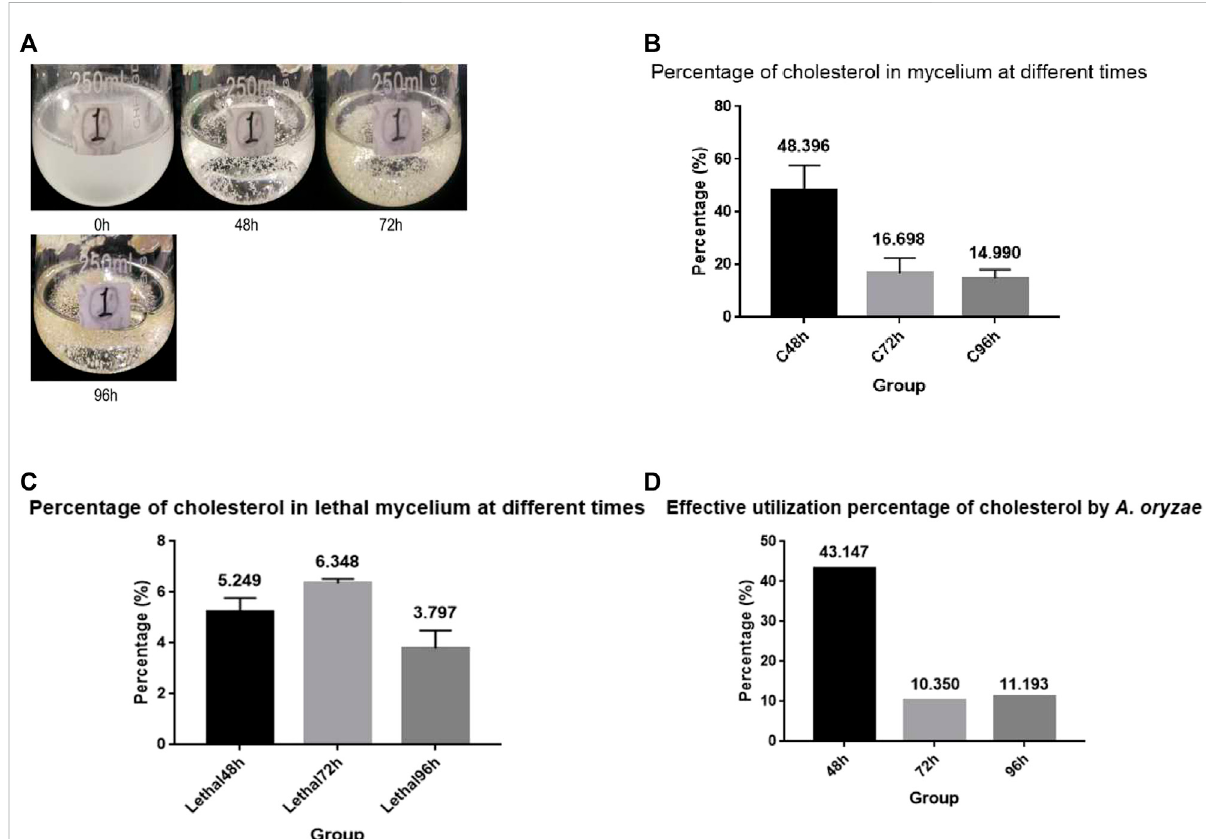
FIGURE 1 A.oryzae canutilizecholesterol. (A) Cholesterolmediumwasfermentedby A.oryzae ,andthegrowthconditionof A.oryzae indifferentperiods of fermentation were determined. (B) The percentage of cholesterol in mycelium dry weight at different time points. (C) The percentage of cholesterolinlethalmyceliumdryweightatdifferenttimepoints. (D) Effectiveabsorptionpercentageofcholesterolby A.oryzae .Threeindependent experiments were